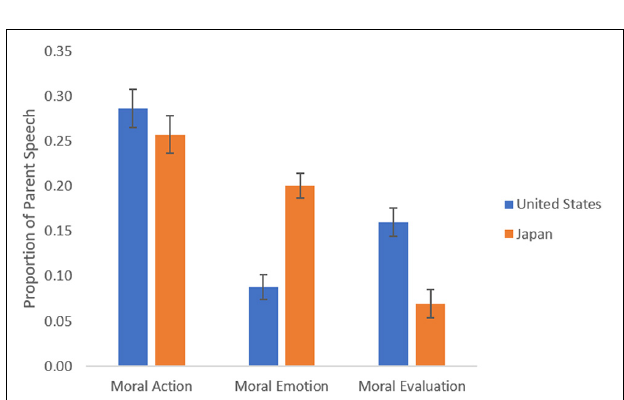
FIGURE 2 | Cross-cultural differences in moral attentional foci in parental narratives. Error bars represent the ± 1 standard error (SE).